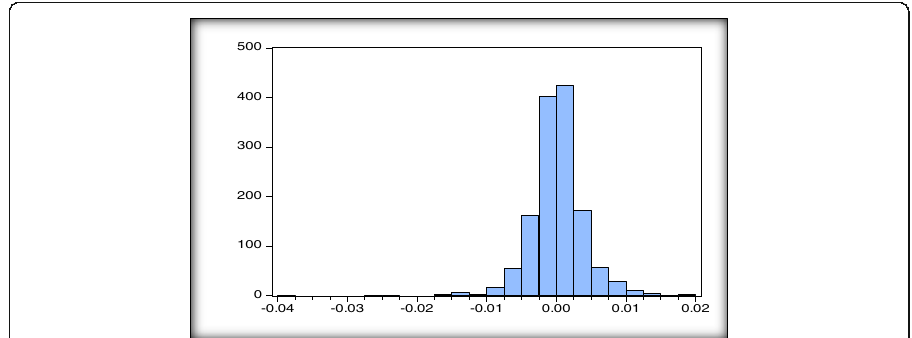
Fig. 2 Histogram representing the difference in log price of GOLDMAN SACHS GETF. In the histogram, the horizontal axis represents the difference in log price and the vertical axis represents the number of times each value occurs, i.e.: it is the probability density function of the difference in log price of GOLDMAN SACHS GETF